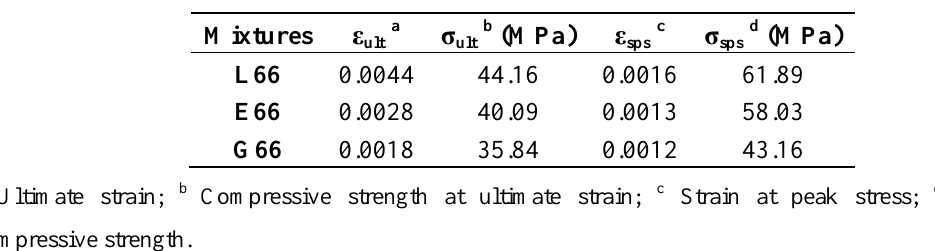
Table 2. Ultimate strain, compressive strength at ultimate strain, strain at peak stress and unconfined compressive strength of the neat geopolymer and of the hybrid composite specimens.